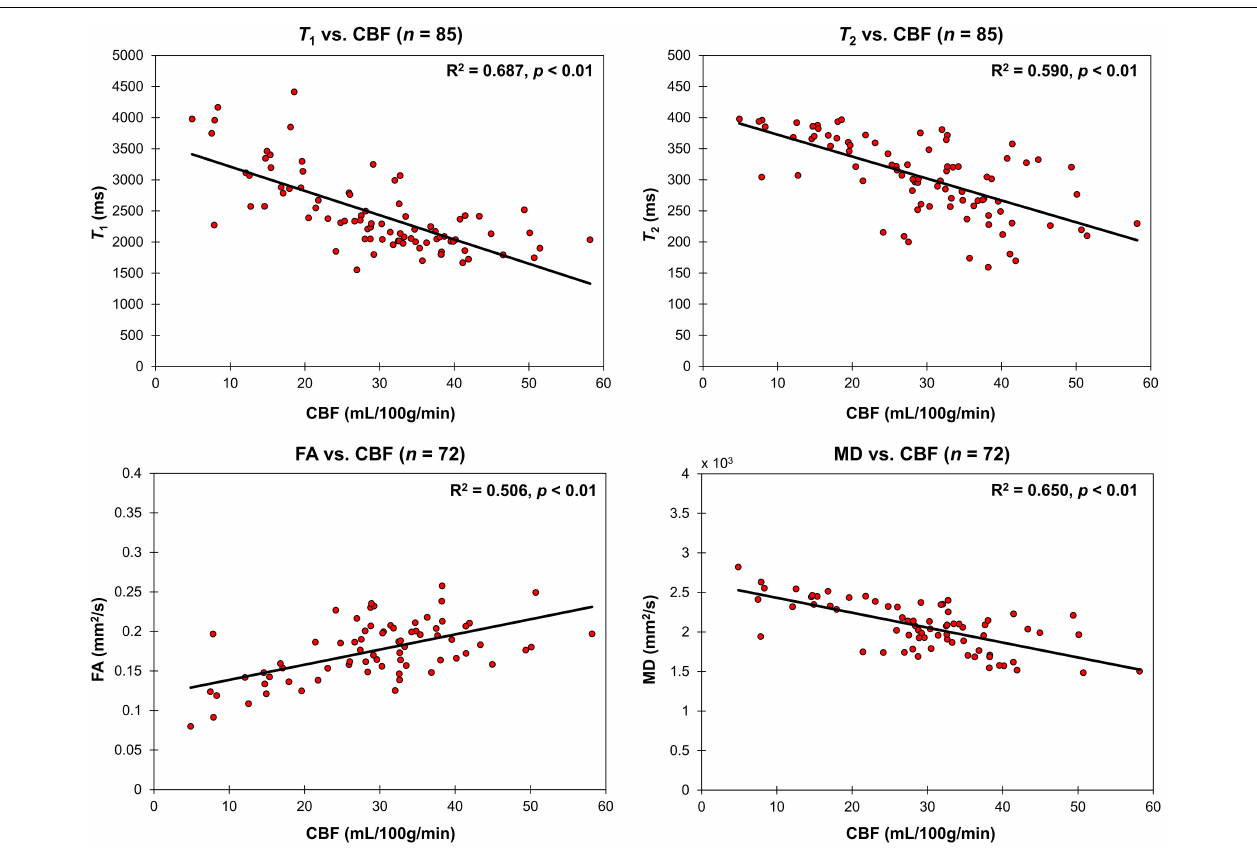
FIGURE 4 | Regressions of relaxometry measures (T 1 and T 2 ) or DTI measures (FA and MD) with CBF in the CP. For each plot, the coefficient of determination, R 2 , and p -value, p , are reported. T 1 , T 2 , and MD all linearly decreased with CBF while FA linearly increased with CBF.